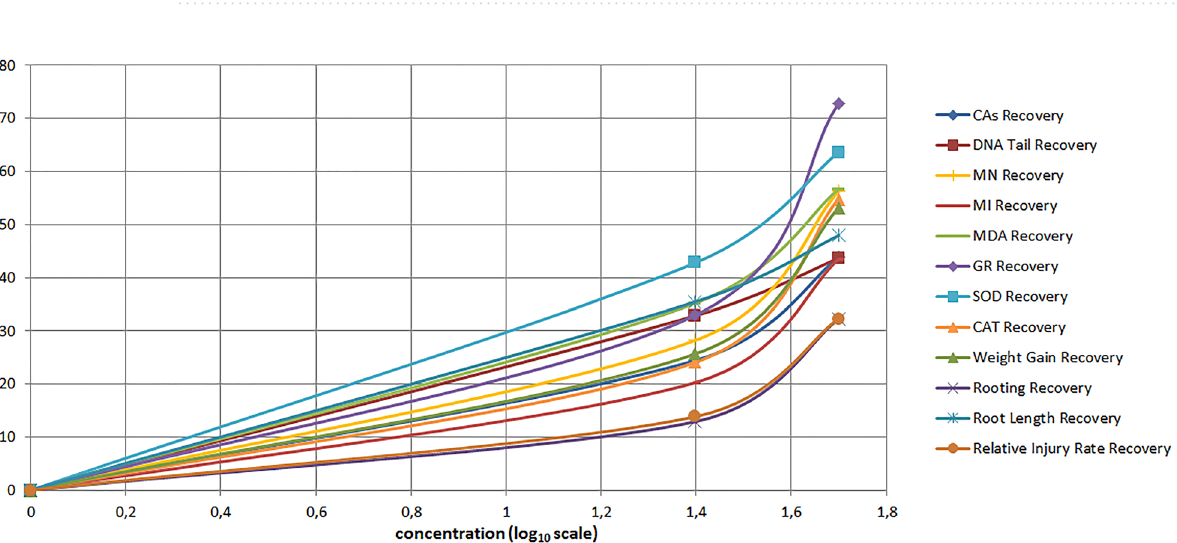
Table 7. The binding energy and molecular interactions of the penoxsulam with DNA molecules. Nucleic acids; A Adenine, C Cytosine, G Guanine, T Thymine.